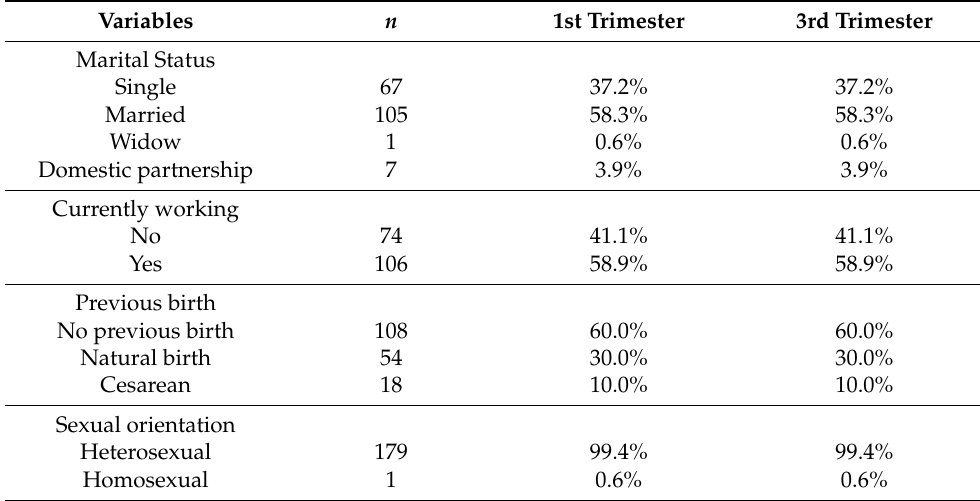
Table 1. Socio-demographic